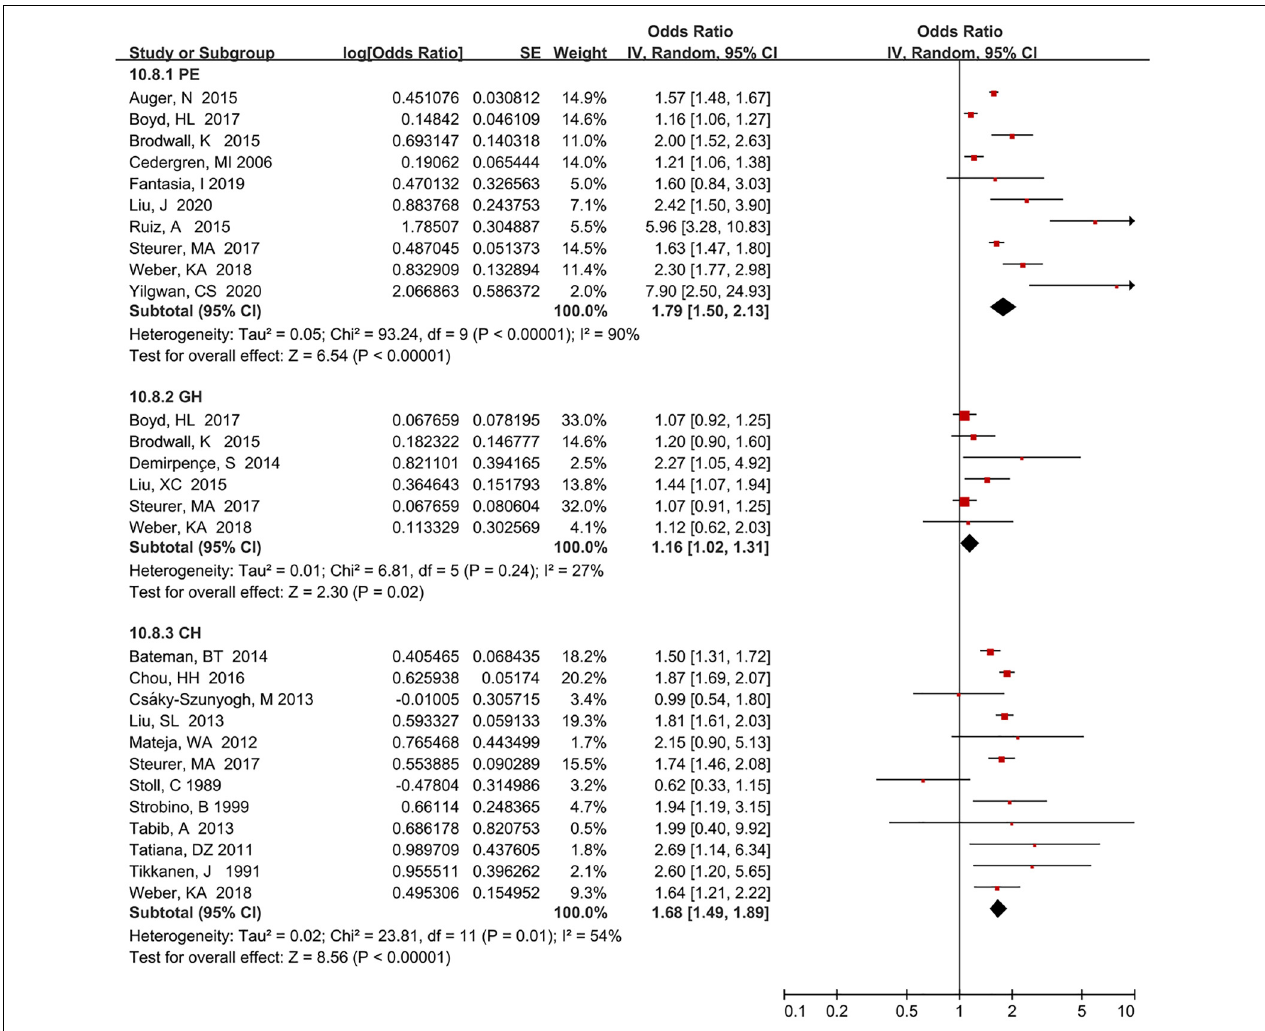
FIGURE 4 | Forest plot of different types of HDP exposure and risk of total CHDs in